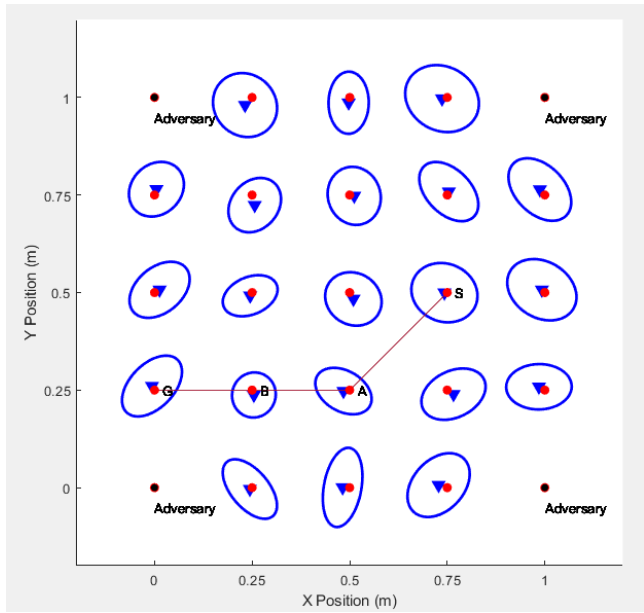
Figure 9. The Route Detected by Adversaries After Intercepting the Sensor’s True Identity.